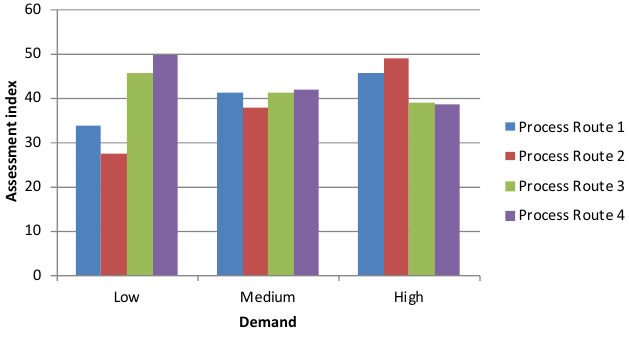
Figure 12. Overall sustainability assessment of the four process routes.